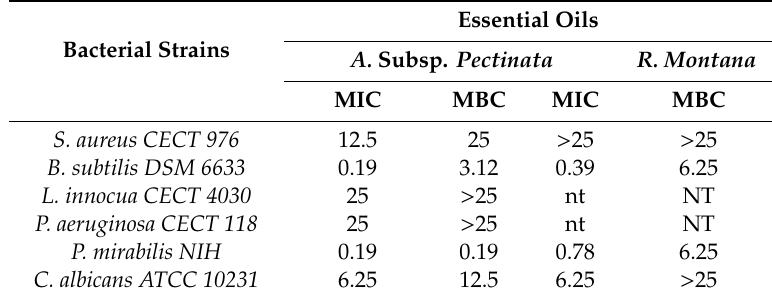
Table 4. The Minimum Inhibitory Concentration (MIC) and Minimum Bactericidal Concentration (MBC) (mg / mL) of A. odorata subsp. pectinata and R. montana essential oils. Essential Oils Bacterial Strains A. Subsp. Pectinata MIC MBC MIC